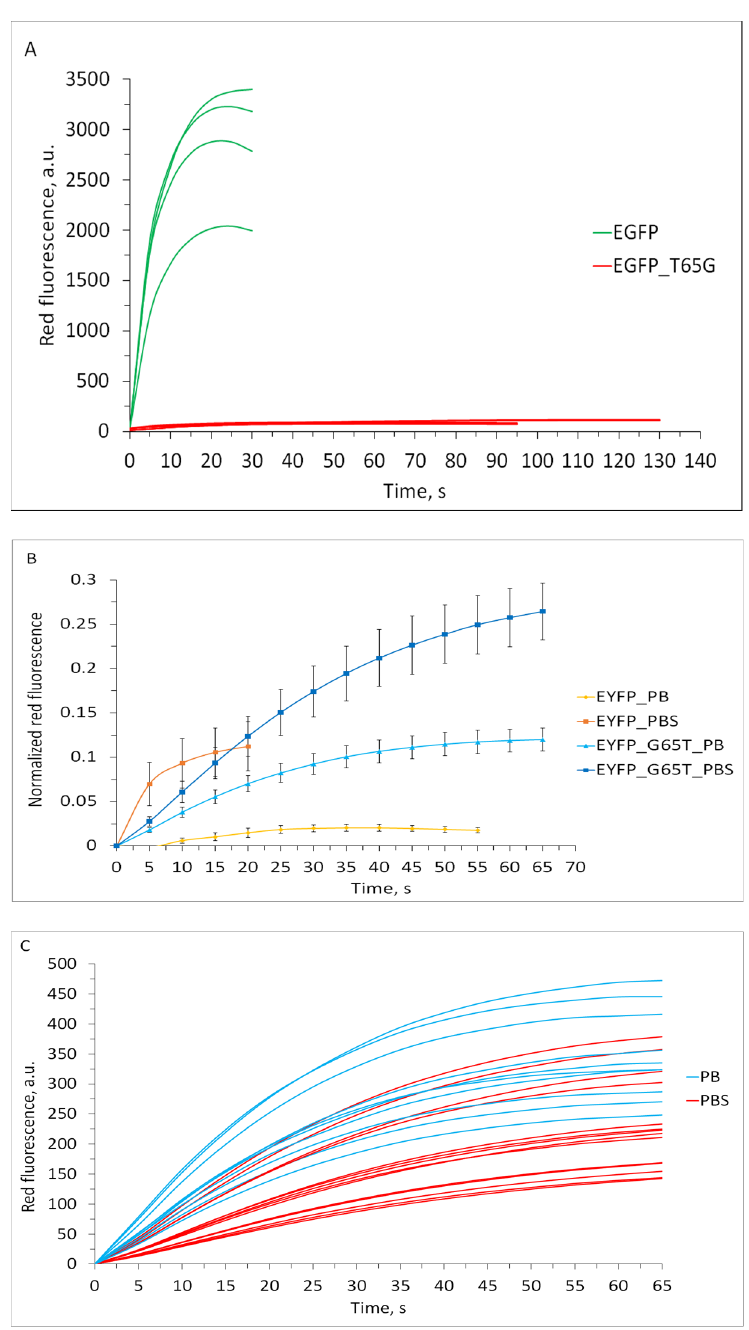
Figure 3. Redding kinetics in the EGFP, EYFP, and their mutants. (A) Appearance of red fluorescence in EGFP and EGFP-T65G. Non-normalized data for several measurements are shown. (B) Appearance of red fluorescence in EYFP and EYFP-G65T in PB and PBS (PBS contains potassium chloride). Averaged curves are shown. Red fluorescence intensities were background-subtracted and normalized to the maximum values. Standard deviation values ( n = 15 − 20 measurements in a representative experiment out of five independent experiments) are shown. (C) Appearance of red fluorescence in EYFP-G65T in PB and PBS (PBS contains potassium chloride). Non-normalized data for several measurements are shown.